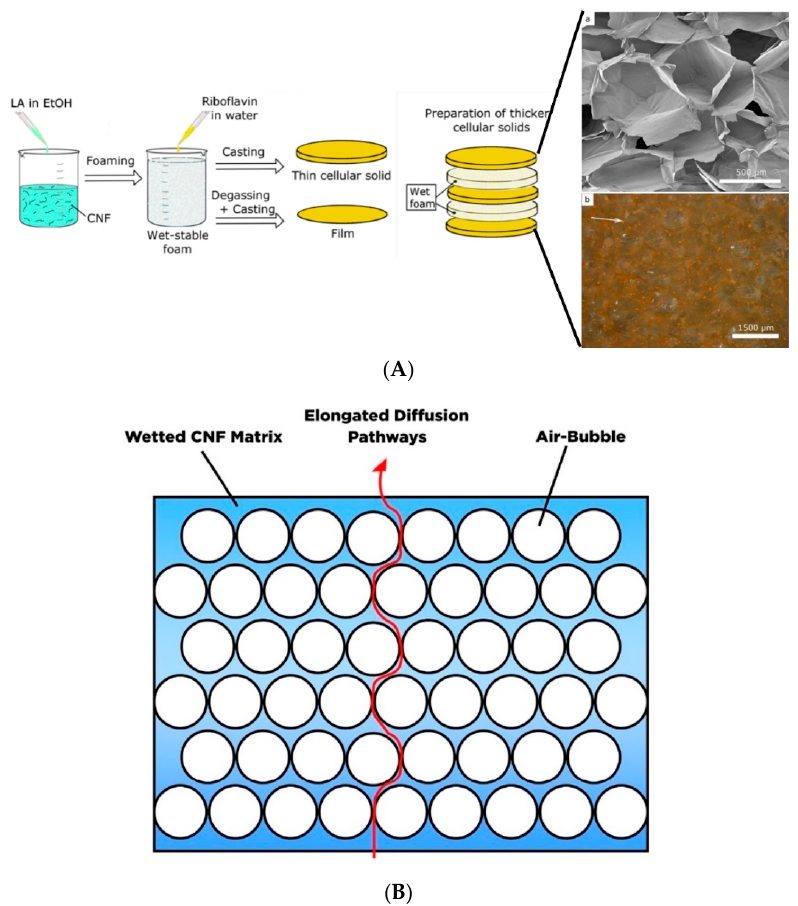
Figure 15. ( A ). Preparation route of CNF-based foams and its morphological, structural characteristic: ( a ): CNF-based foams cross-section morphological image; ( b ) cell structure image of CNF/LA loaded with riboflavin (the arrow points to riboflavin). ( B ) elongated diffusional pathways of the drug in foam-based CNFs (this figure is redrawn from Svagan et al. [189]. Copyright © 2016 Elsevier